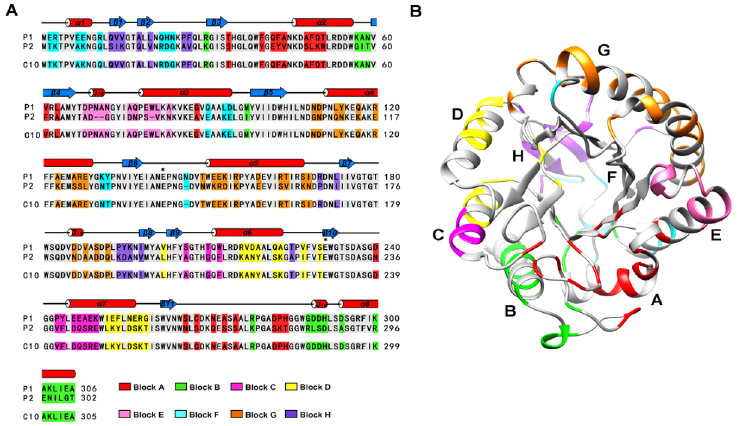
Fig 1. Sequence alignment and noncontiguous blocks of the cellulases GsCelA and BsCelA. (A) The C10 chimera sequence is aligned with P1 and P2 parental sequences. Residues in the α -helices and β - strands are indicated by red cylinders and blue arrows, respectively. P1 is the catalytic core of thermostable GsCelA from Geobacillus sp. 70PC53, and P2 is the catalytic core of Bacillus subtilis 168 BsCel5A. The asterisks indicate catalytic acids and bases. (B) Noncontiguous blocks in the designed GH5 chimera. The eight noncontiguous blocks indicated by colored regions were calculated using the SCHEMA program at < E > = 16.25 and < m > = 47. Amino acids that are the same in both parent enzymes are shown in grey.